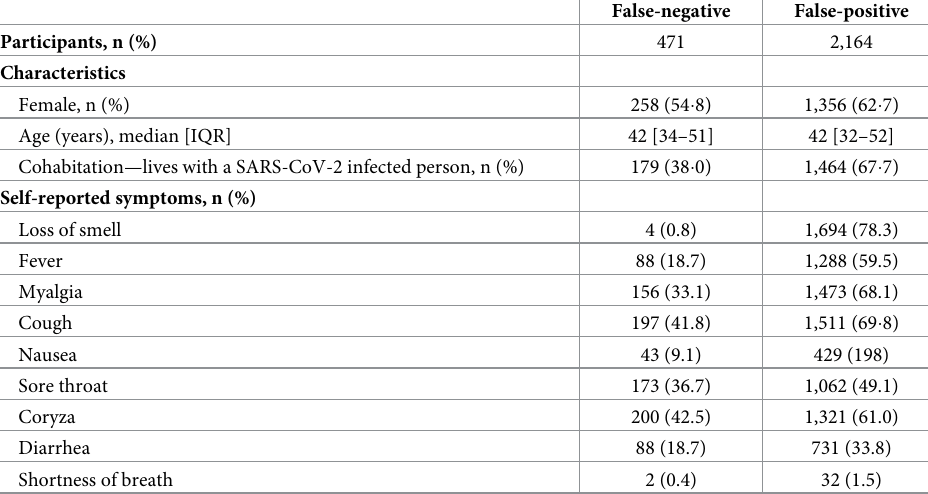
Table 2. Characteristics and symptoms of false-negative and false-positive users predicted from our model.